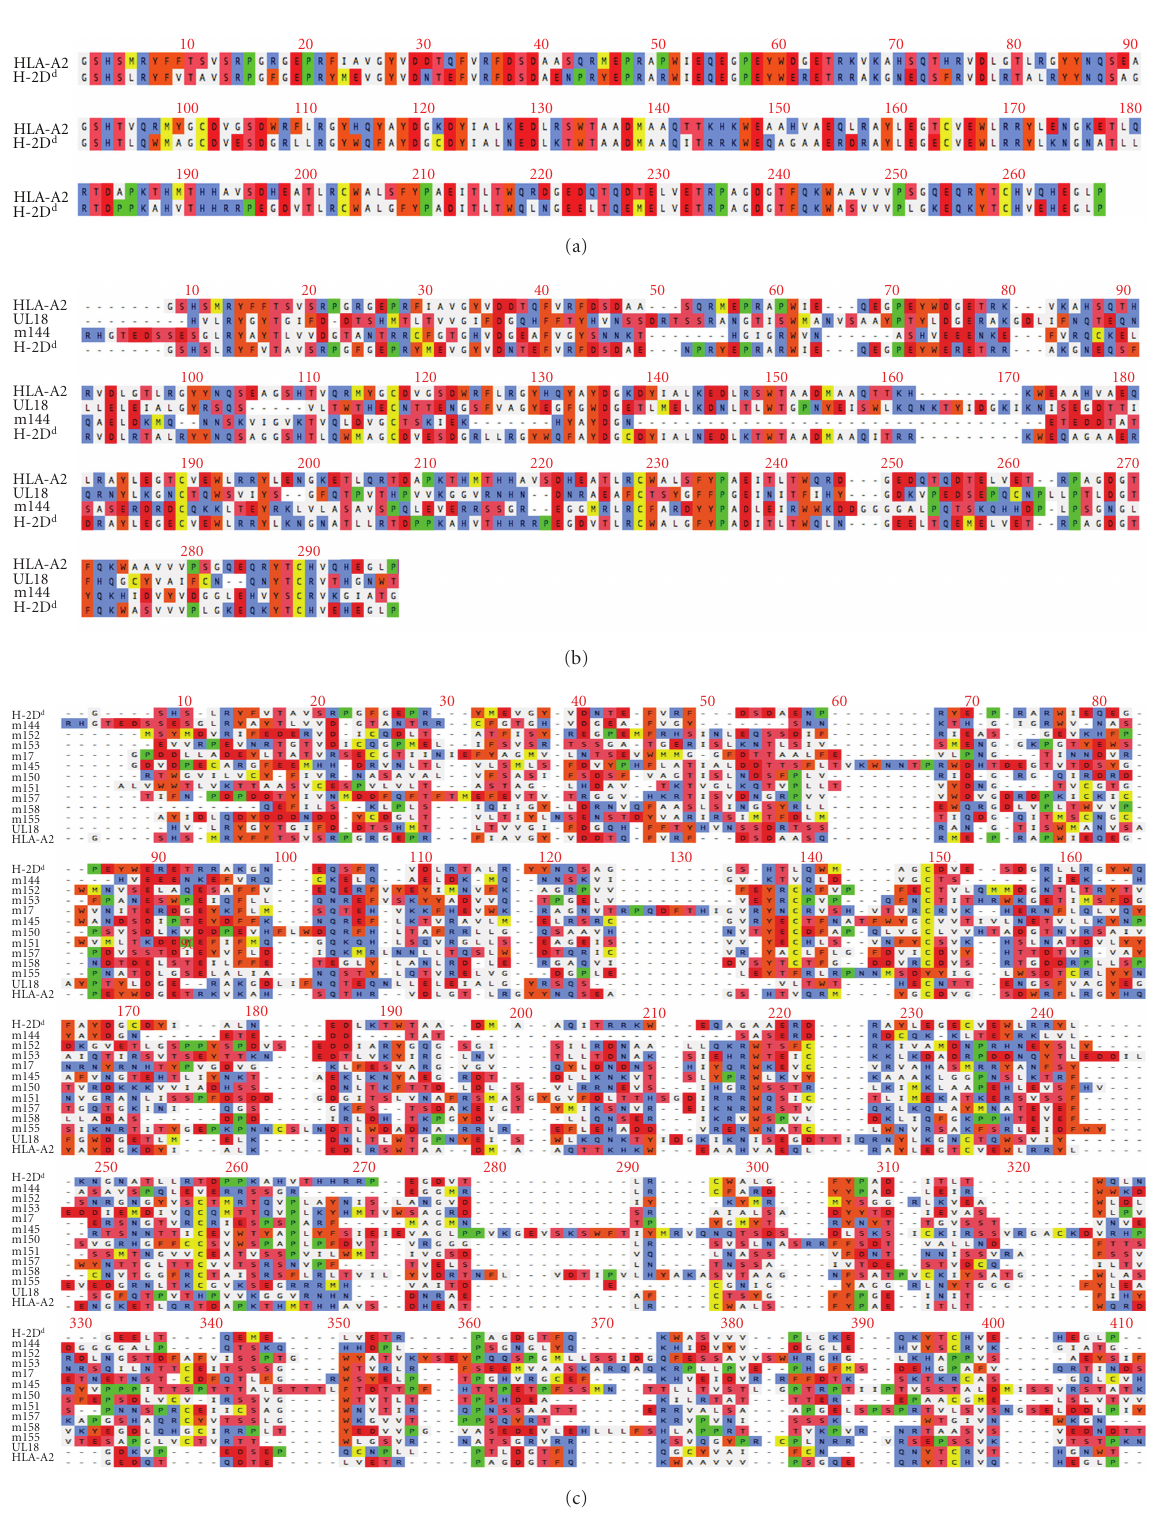
Figure 2: Amino acid sequence alignments of the extracellular domains of classical MHC-I molecules from mouse (H-2D d ) and human (HLA-A2) with MHC-I-like viral immunoevasins were generated using ClustalW module of MacVector 10.6.6. H-2D d and HLA-A2 share significant similarity at 81.7% (a). UL18 and m144 show detectable sequence similarity (21–40%) with HLA-A2 and H-2D d . Conserved cysteine residues are in yellow (b). The alignment of m145 family members and other MHC-I-like immunoevasins shows 6–40% sequence similarity to the canonical MHC-I molecules